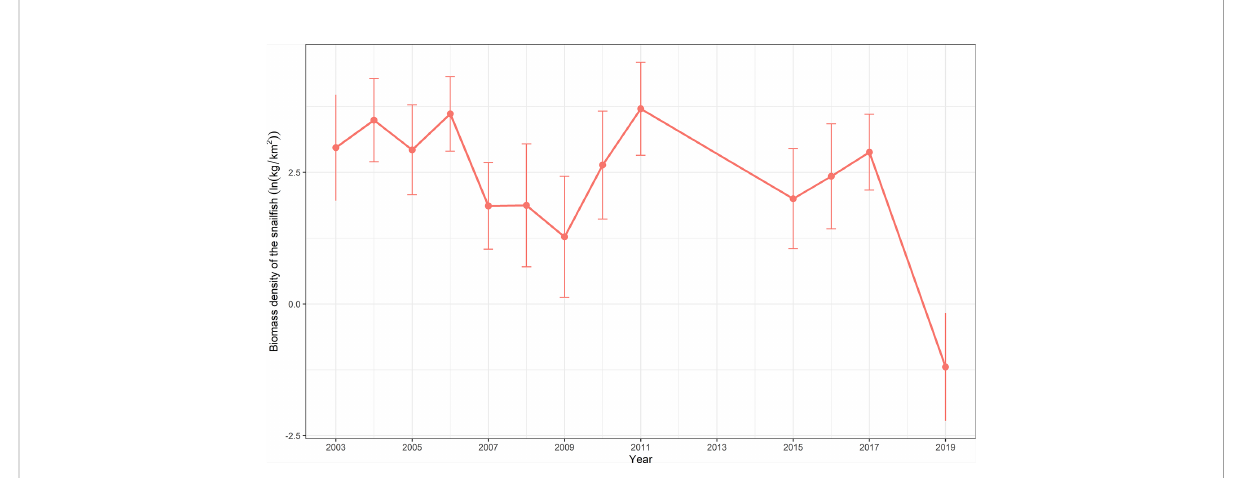
FIGURE 4 Biomass density (ln(kg/km 2 )) time series generated by VAST for snail fi sh in the Yellow Sea in 2003 – 2019. Data are expressed with mean ± standard